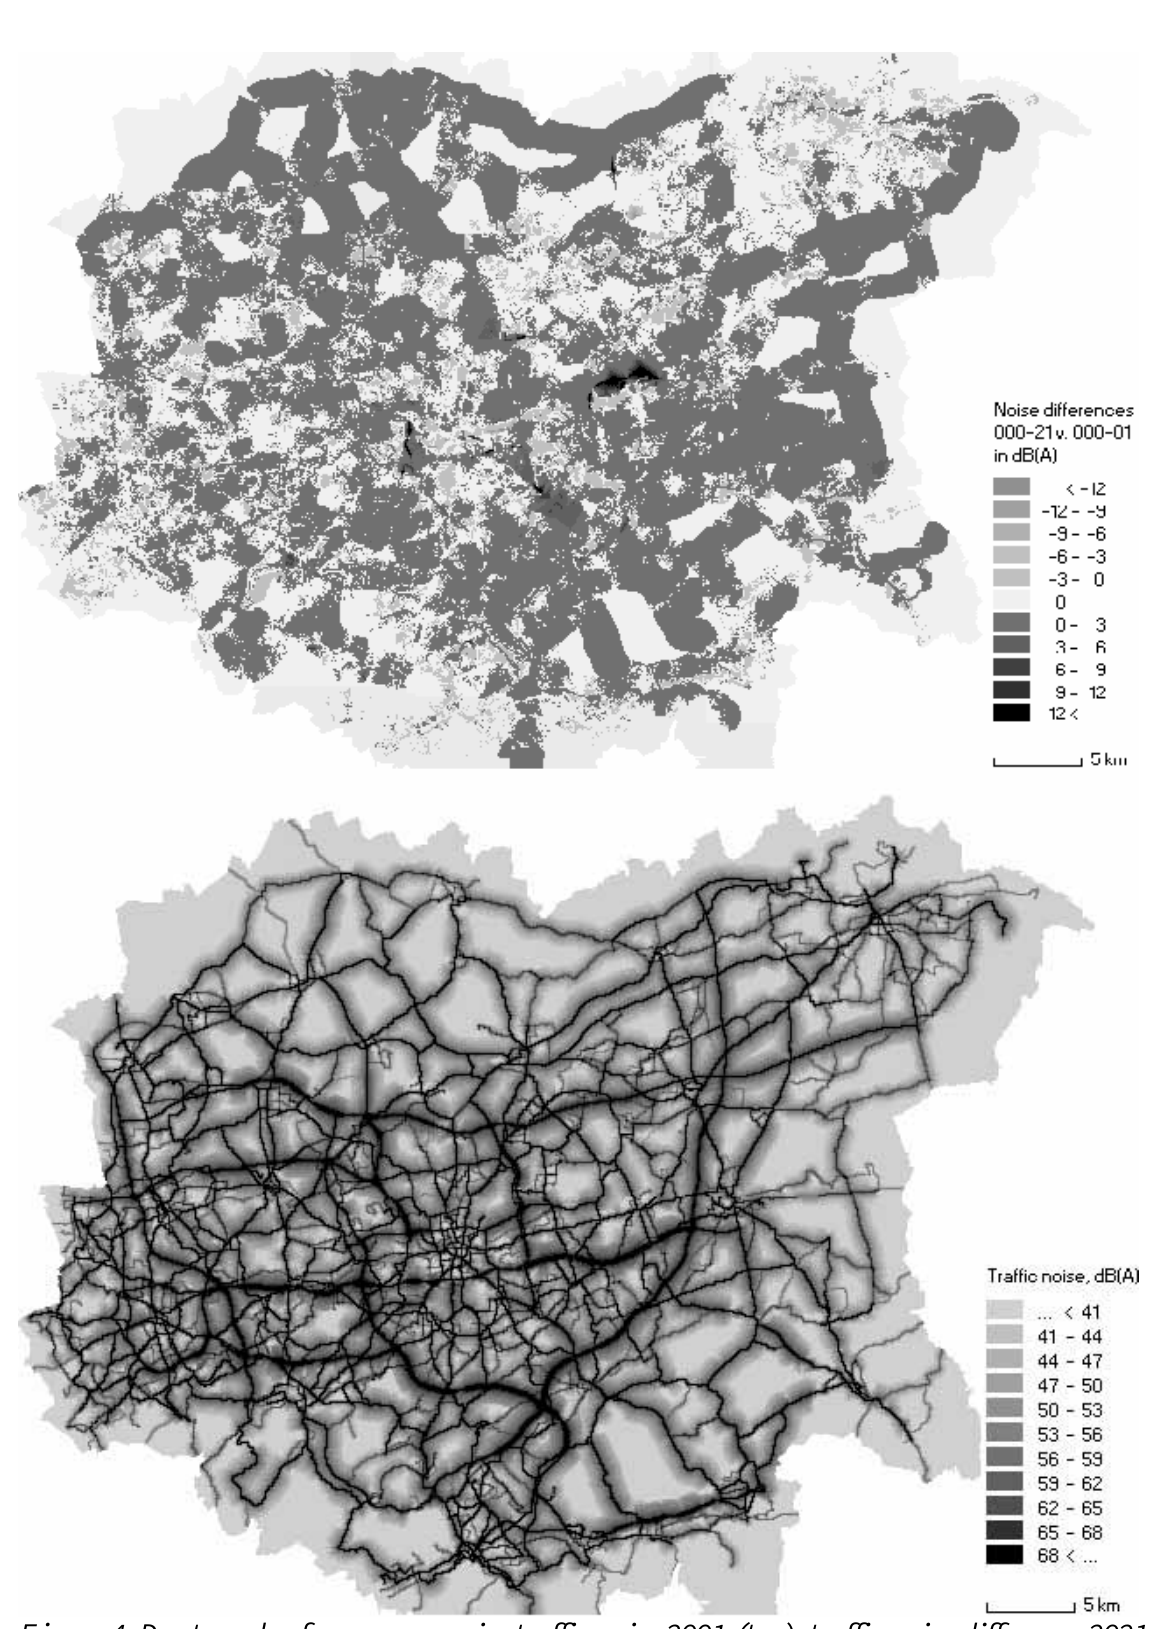
Figure 4. Dortmund reference scenario, traffic noise 2001 (top), traffic noise difference 2021 v. 2001